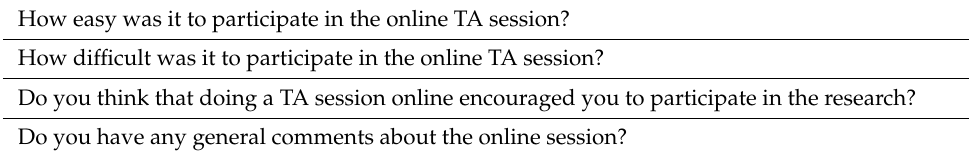
Table 1. Semi-structured interview